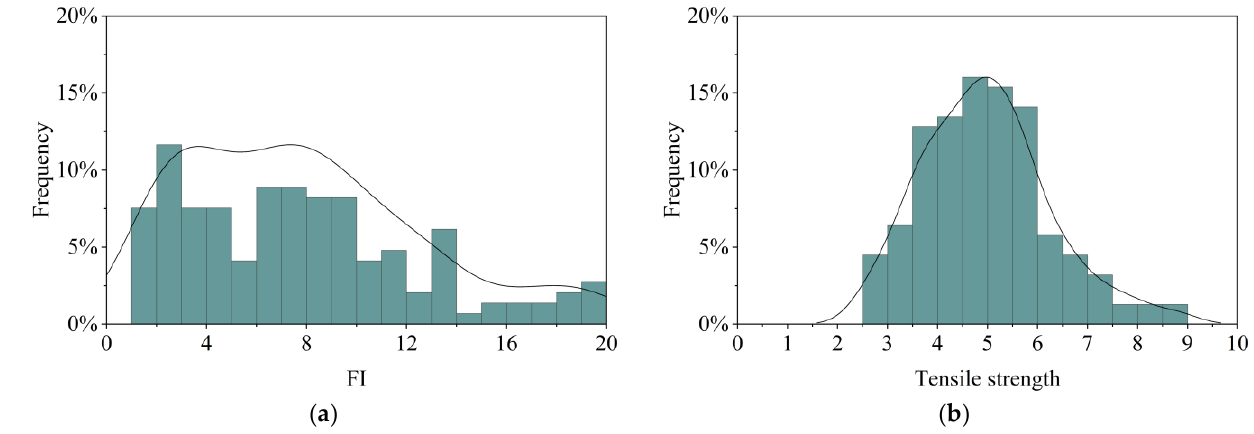
Figure 6. Distribution of ( a ) FI and ( b ) tensile strength. Analysis of variance (ANOVA) is a valid method used to investigate whether different levels of control variables have significant effects on observation variables. In this study, ANOVA was performed to evaluate the effect of these factors on the cracking resistance of the three asphalt layer samples. A probability value ( p -value) less than the significance level (0.05) indicated that the factor was statistically significant. The following five factors were considered: air void, mixture type, service age, ESALs, and overload rate. The